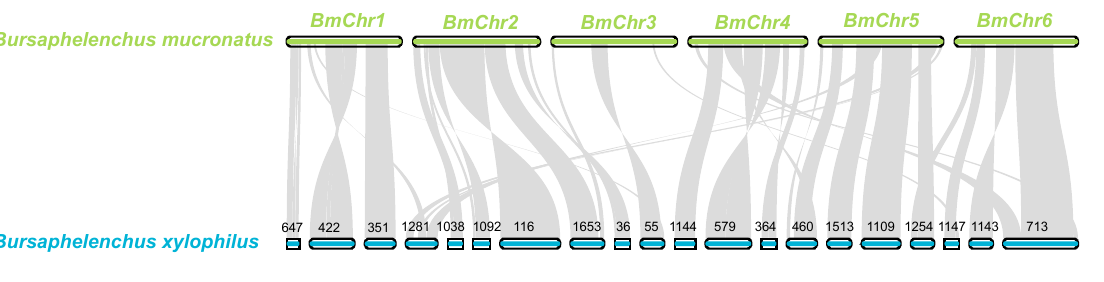
Figure 5. Genome synteny between B. mucronatus and B. xylophilus . Genomic alignments between B. xylophilus (Sequence length > 1 Mb) and B. mucronatus showed high similarity of synteny. The alignments regions are marked with grey ribbons.